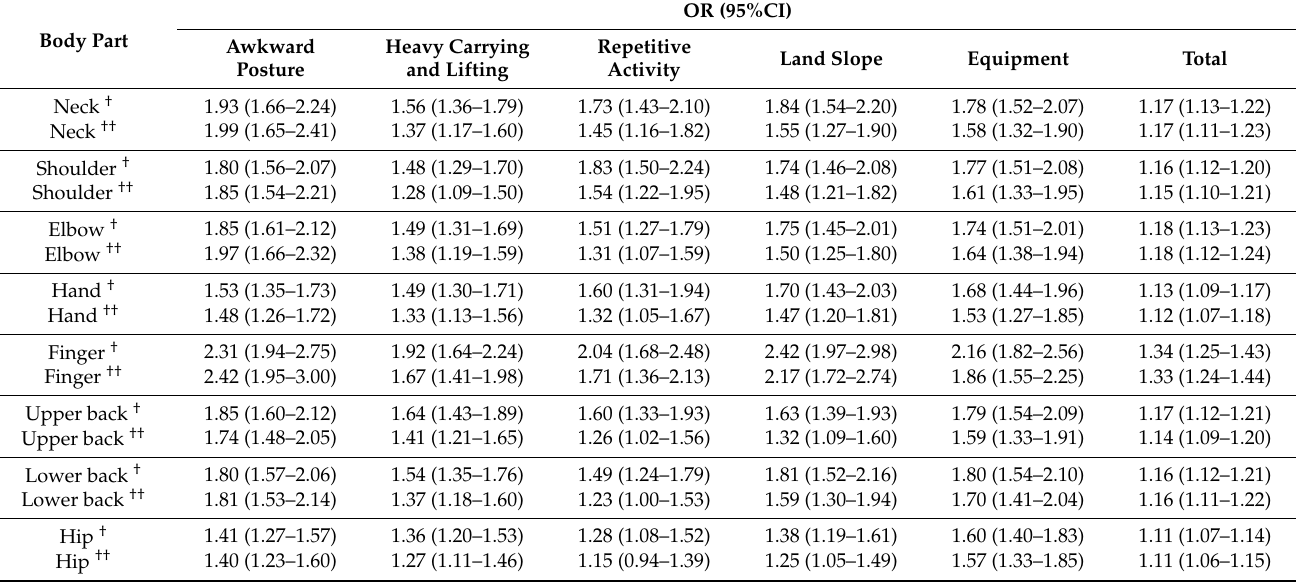
Table 5. The ergonomic risk factors associated with MSDs in body parts among ethnic lychee–longan harvesting